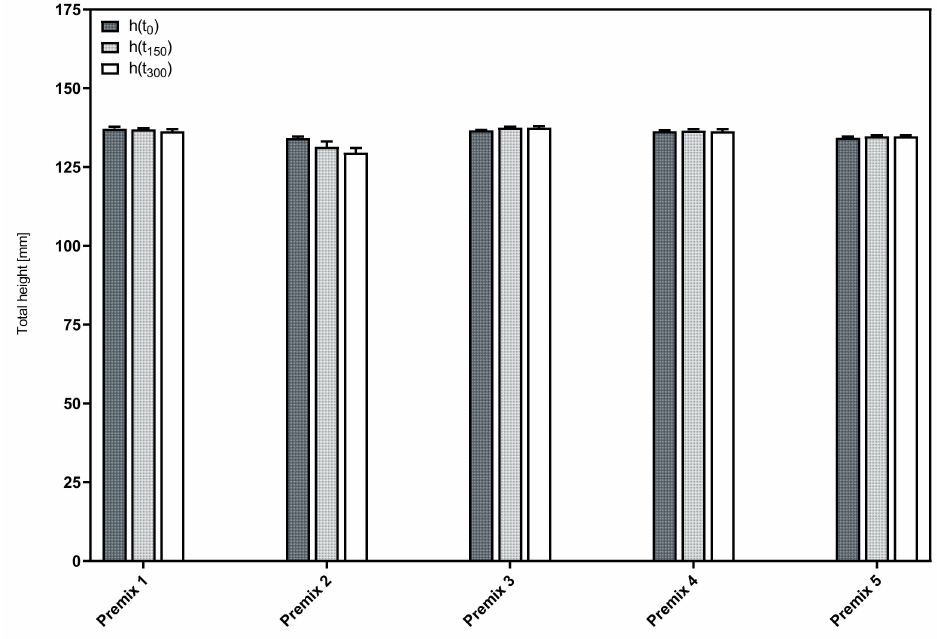
Figure 4. Time course of the total foam height of the aqueous phospholipid premixes; mean ± SD, n = 3.